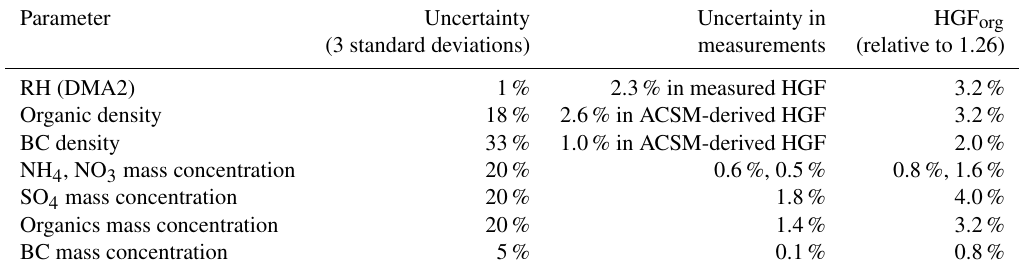
Table 2. Sources of uncertainties associated within hygroscopicity-composition closure, given in terms of three standard deviations and their corresponding contribution to the overall uncertainty in hygroscopicity-composition closure. Parameter Uncertainty Uncertainty in HGF org (3 standard deviations) measurements (relative to 1.26) 3.2% 18% 2.6% in ACSM-derived HGF